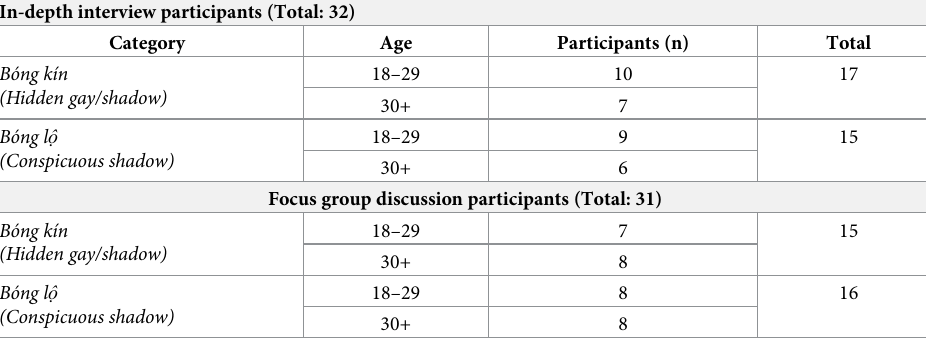
Table 1. Demographics of the MSM from the in-depth interviews and focus groups. In-depth interview participants (Total: 32)